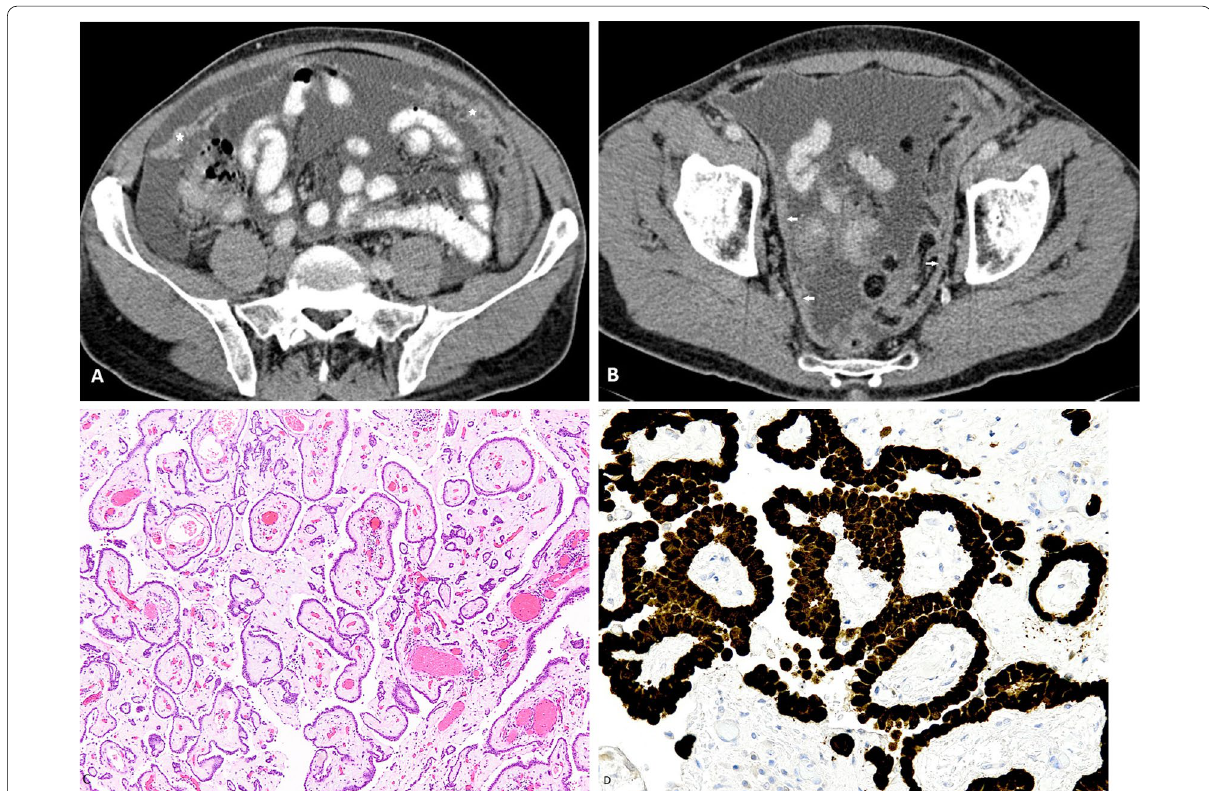
Fig. 4 a – d 42-year-old female with well-differentiated papillary mesothelioma of the peritoneum. a , b CT axial images showing moderate volume ascites, plaque-like peritoneal thickening (arrow) and omental cake (*). c Low power photomicrograph (H&E, by a layer of cuboidal mesothelial cells. d High-power photomicrograph (calretinin immunostaining, cells confirming mesothelial